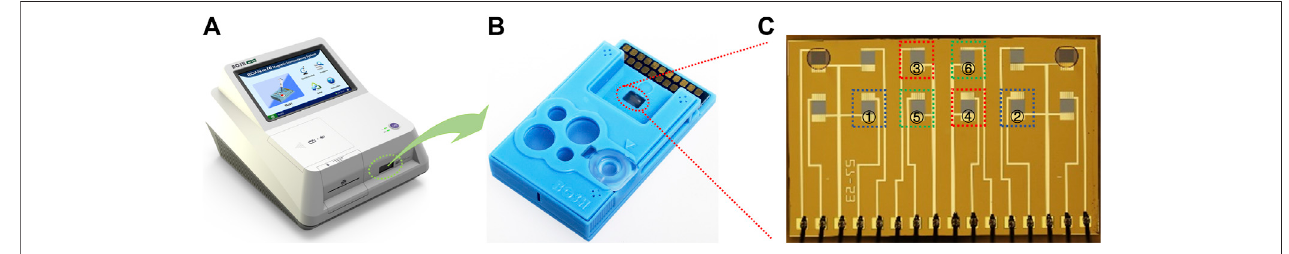
units used for NGAL detection are marked in green squares ( ⑤ and ⑥ ).